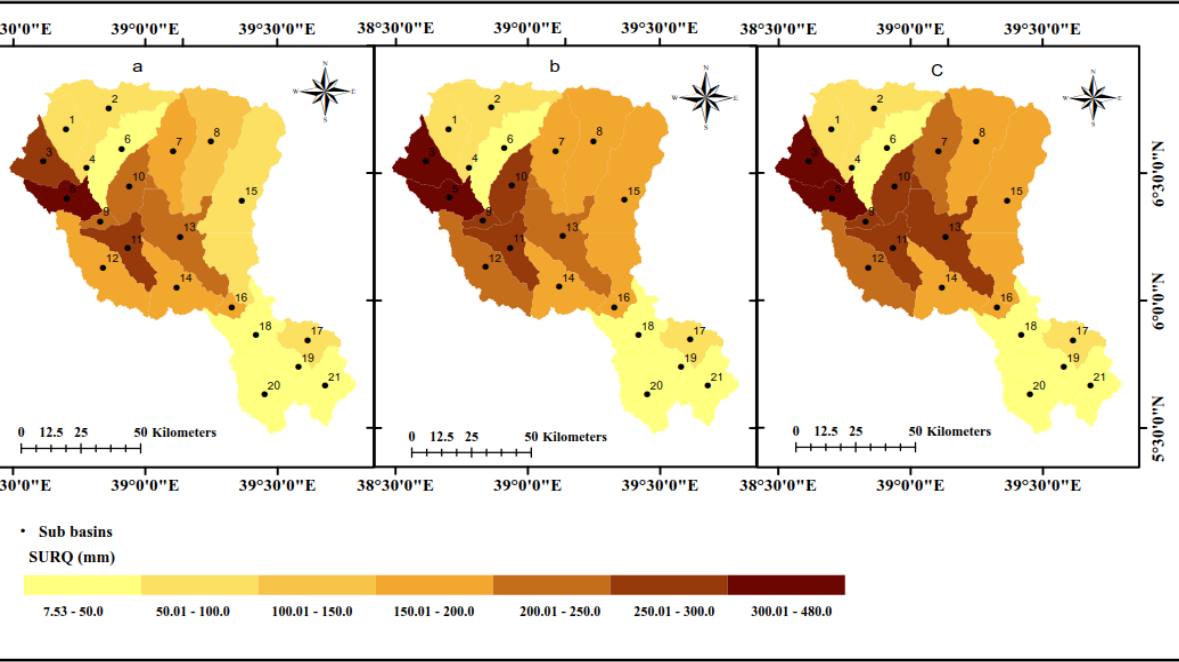
Figure 10. Simulated spatial distribution of evapotranspiration for ( a ) 1986, ( b ) 2001, and ( c ) 2016 LULC scenarios.